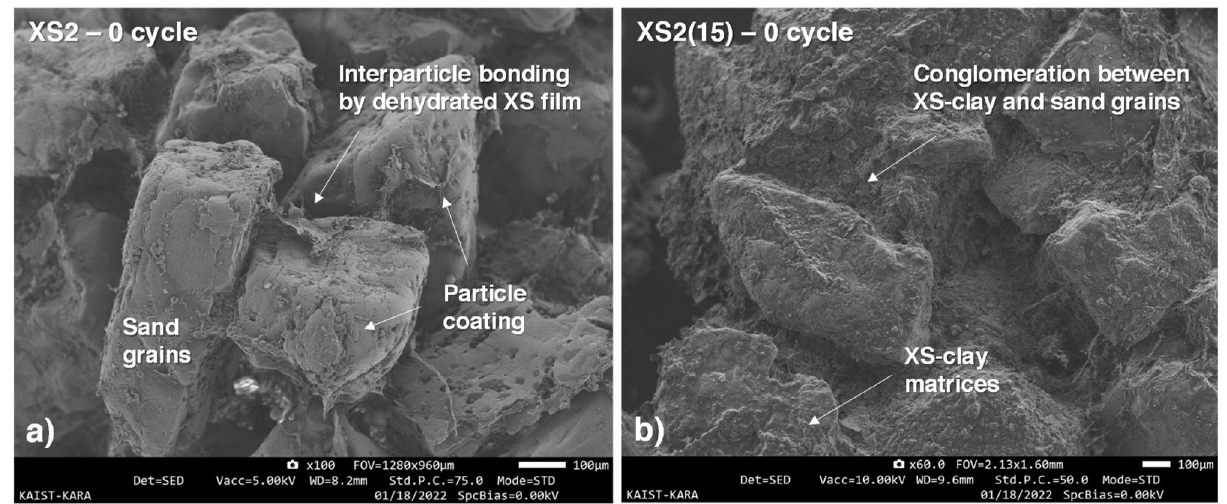
Figure 6. SEM images of unexposed XS-treated soil. ( a ) XS2, and ( b )